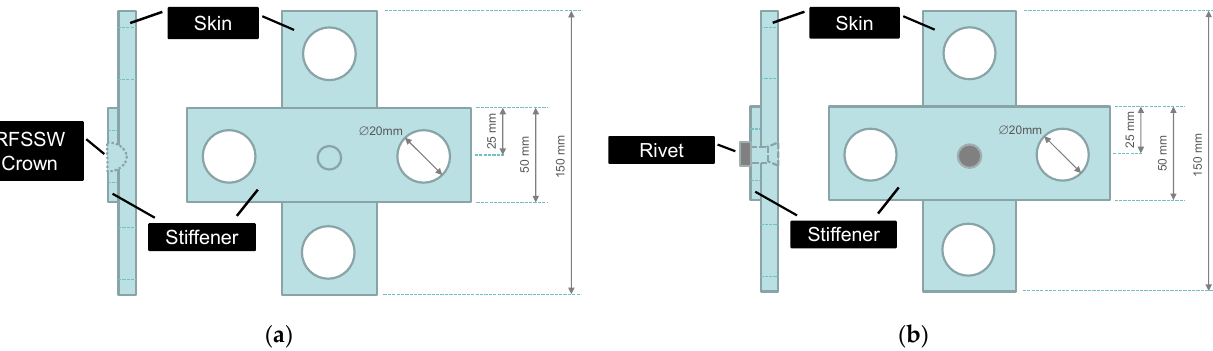
Figure 5. Cross-coupon configurations in accordance with ISO-14272: ( a ) RFSSW cross-coupon configuration and ( b ) rivet cross-coupon configuration.